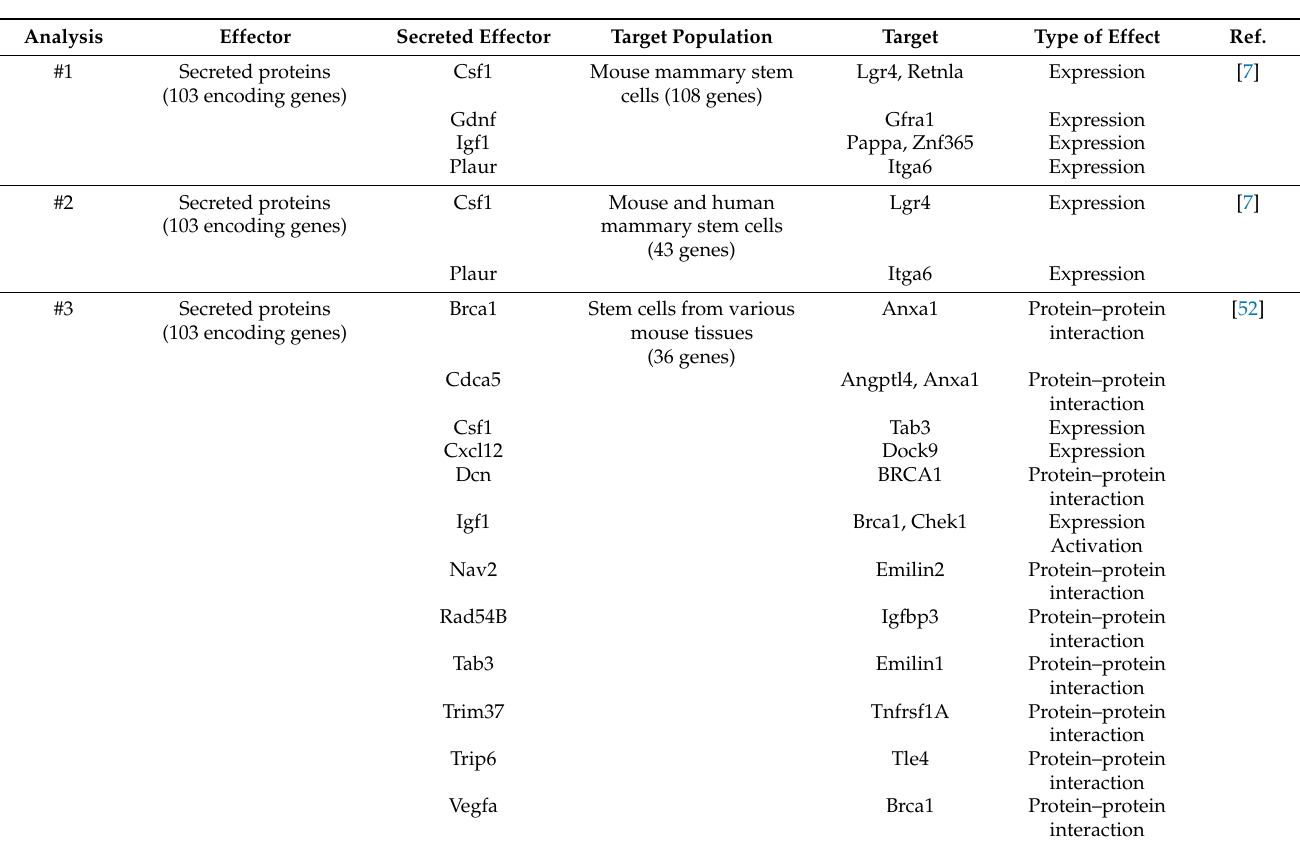
Table 1. IPA analysis of genes encoding secreted proteins that are highly expressed in calorie- restriction (CR)-treated mice, compared to their ad libitum-fed counterparts and interact with reported stem cell